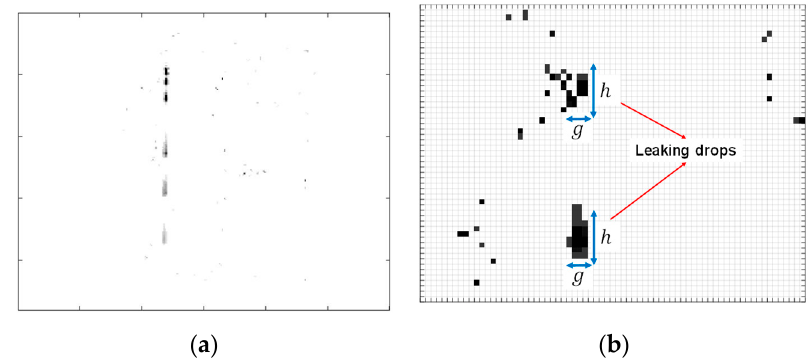
Figure 2. Object definition for leakage detection. ( a ) The fading problem in leakage detection. Leaking drops lose temperature, and therefore the intensity of the pixels gets less when they reach the bottom of the frame. ( b ) Zoomed area in a frame and object definition for leaking drops as a set of points with at least h and g non-zero neighbours in vertical and horizontal directions,